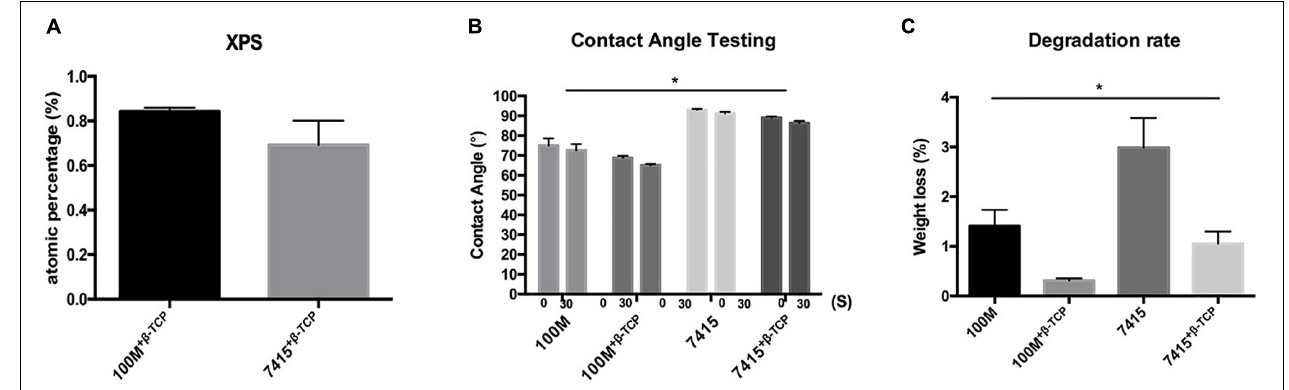
FIGURE 3 | Scaffold characterization. (A) X-ray photoelectron spectroscopy graph of 100M + β - TCP and 7415 + β - TCP showing the surface atomic percentage of calcium phosphate normalized to 100M and 7415, respectively. (B) Contact Angle test represents surface wettability of the materials at 0 s and after 30 s. n = 3, error bars represent ± SD, and * P -value < 0.05. (C) Degradation profile of all materials represents the percentage of weight loss after 21 days of soaking in Tris–HCl. n = 3, error bars represent ± SD, and * P -value < 0.05.